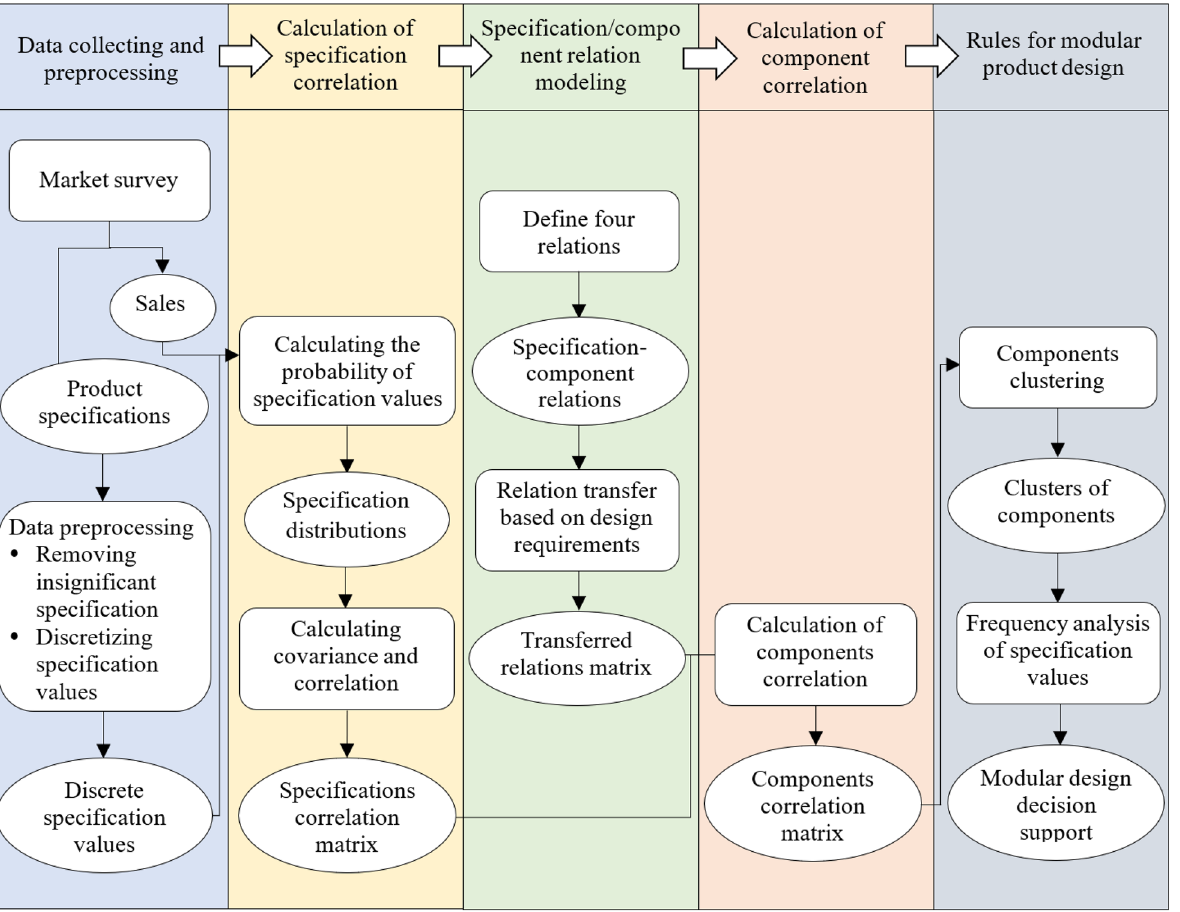
Figure 3 Five phases of the proposed